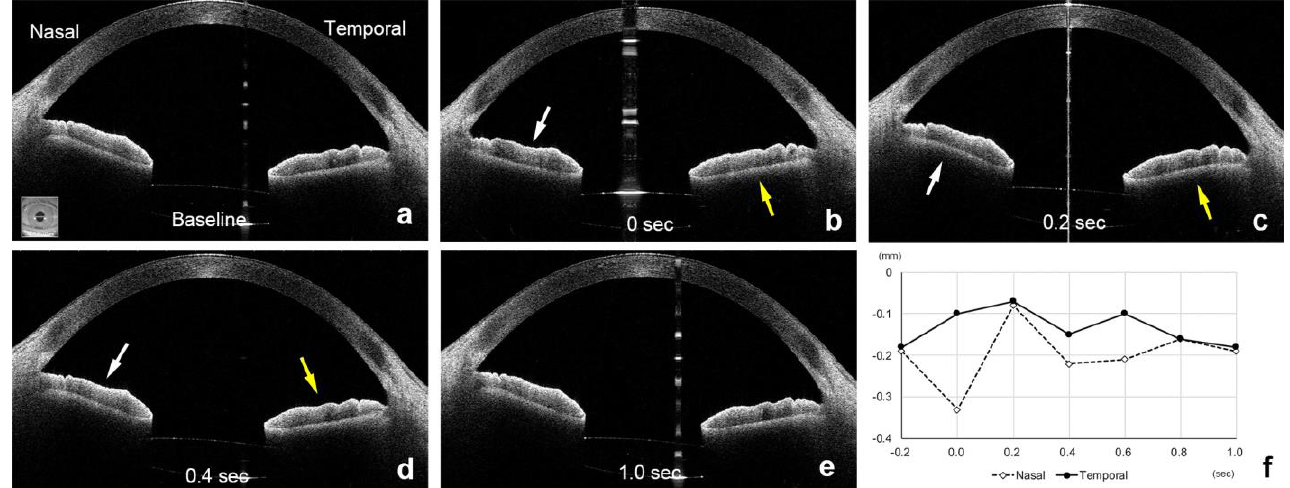
Figure 4. AS-OCT images of a 67-year-old man in the control group who had undergone vitrectomy combined with cataract surgery for an idiopathic macular hole and had the IOL implanted in the capsular bag. The nasal height of the iris (white arrow) decreases at time 0 s ( b ) immediately after the eye stops at the primary position from the baseline ( a ). The nasal height (white arrows) increases at 0.2 s ( c ) and decreases (white arrows) at 0.4 s ( d ). The nasal height returns at 1.0 s ( e ) to the baseline position ( f ). The temporal height of the iris (yellow arrow) increases at 0 s and remains higher at 0.2 s (yellow arrow, c ) and then returns to the baseline position at 0.4 s ( d – f ).